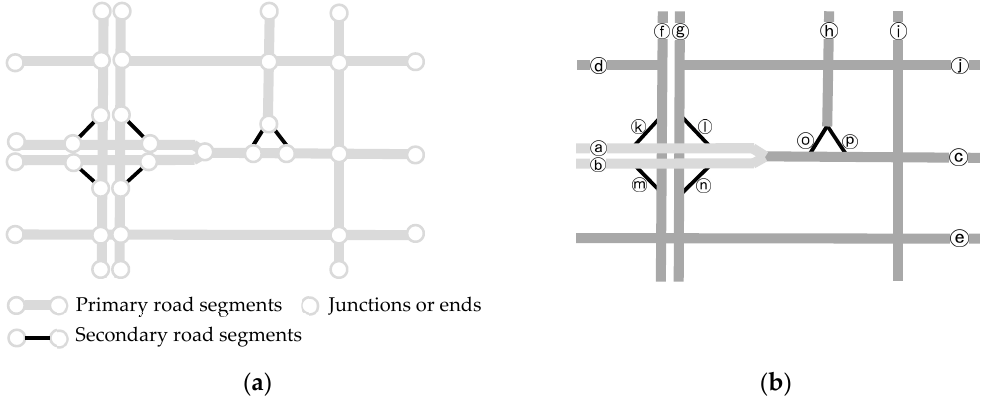
Figure 4. ( a , b ) The global initialization of the schematic road network T. (2) Seeding: pick an unprocessed secondary road sd from SG. If it is an appropriate one (i.e., it connects two different roads instead of the counterparts of one road), proceed to the next step. Otherwise, mark it as processed in SG. Try others till an appropriate one is picked. Or otherwise, return J and quit, as there are no more unprocessed nodes in SG. (3) Local initialization: prepare two empty sets, one for primary roads (P) and the other for secondary ones (S), to collect a complex junction’s boundary nodes and interior nodes respectively. Put sd into S. By picking node k as sd as shown in Figure 5a, S contains a secondary road in its collection as (k) after the local initialization.